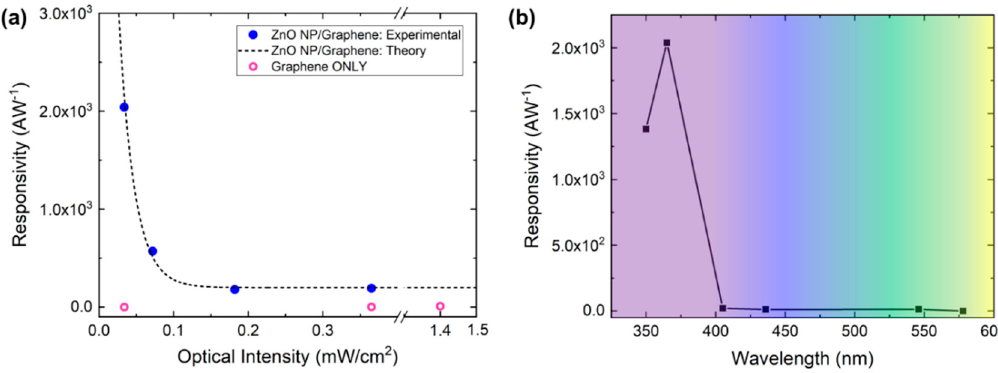
Figure 7. ( a ) Responsivity as a function of optical intensity for both ZnO nanoparticle/graphene devices (solid blue circles) and graphene only devices (open pink circles). Dashed black line represents a simulated fit. ( b ) Responsivity as a function of incident wavelength for ZnO nanoparticle/graphene devices.